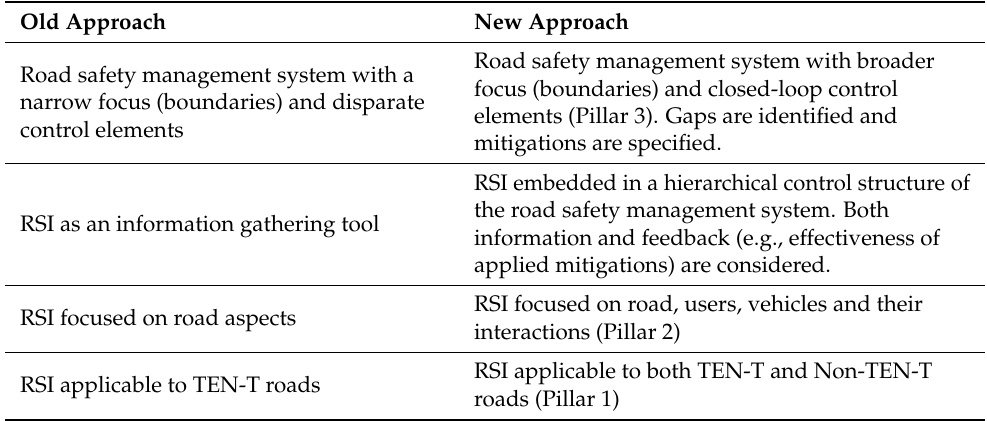
Table 3. Comparison of the old and new approach to road safety